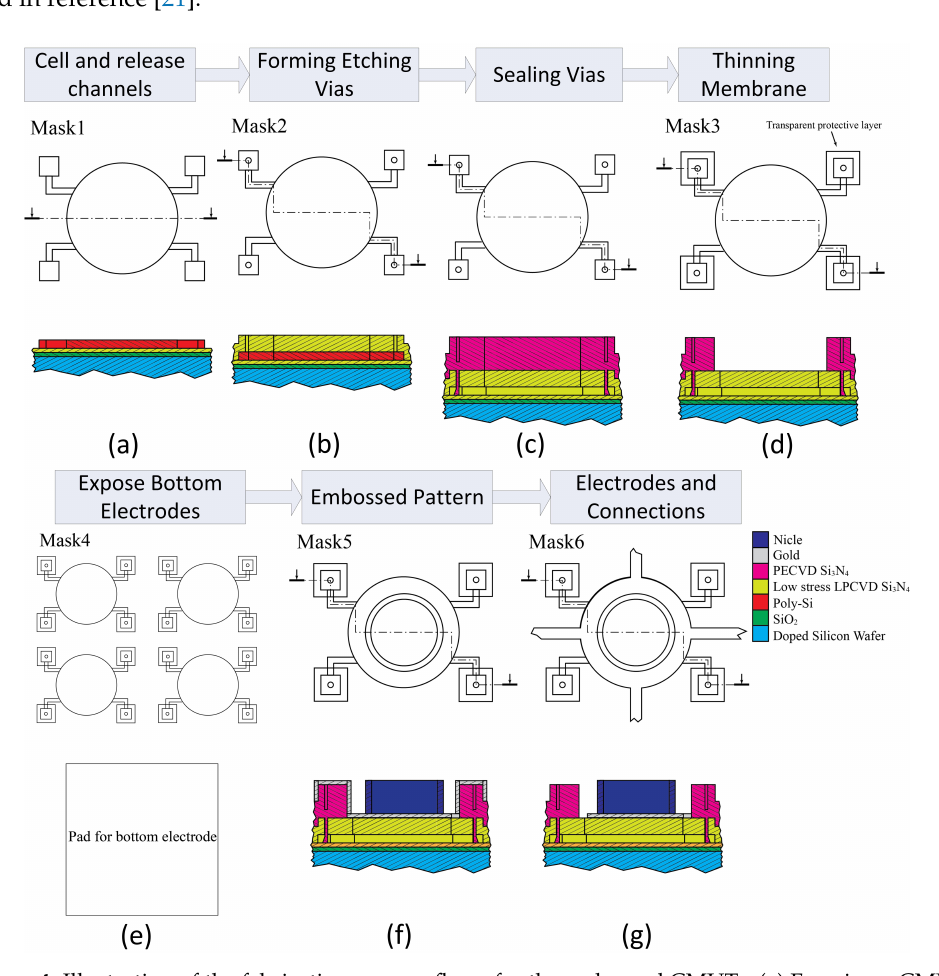
Figure 4. Illustration of the fabrication process flows for the embossed CMUTs. ( a ) Forming a CMUT cell; ( b ) forming etching vias; ( c ) sealing vias; ( d ) thinning the membrane; ( e ) exposing bottom electrodes; ( f ) forming an embossed pattern; ( g ) forming electrodes and